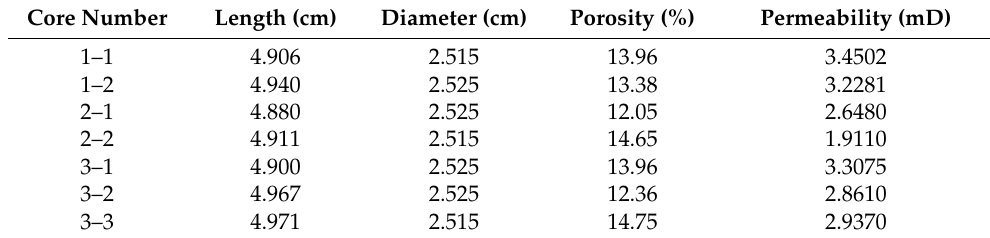
Table 1. Basic data table of core samples.